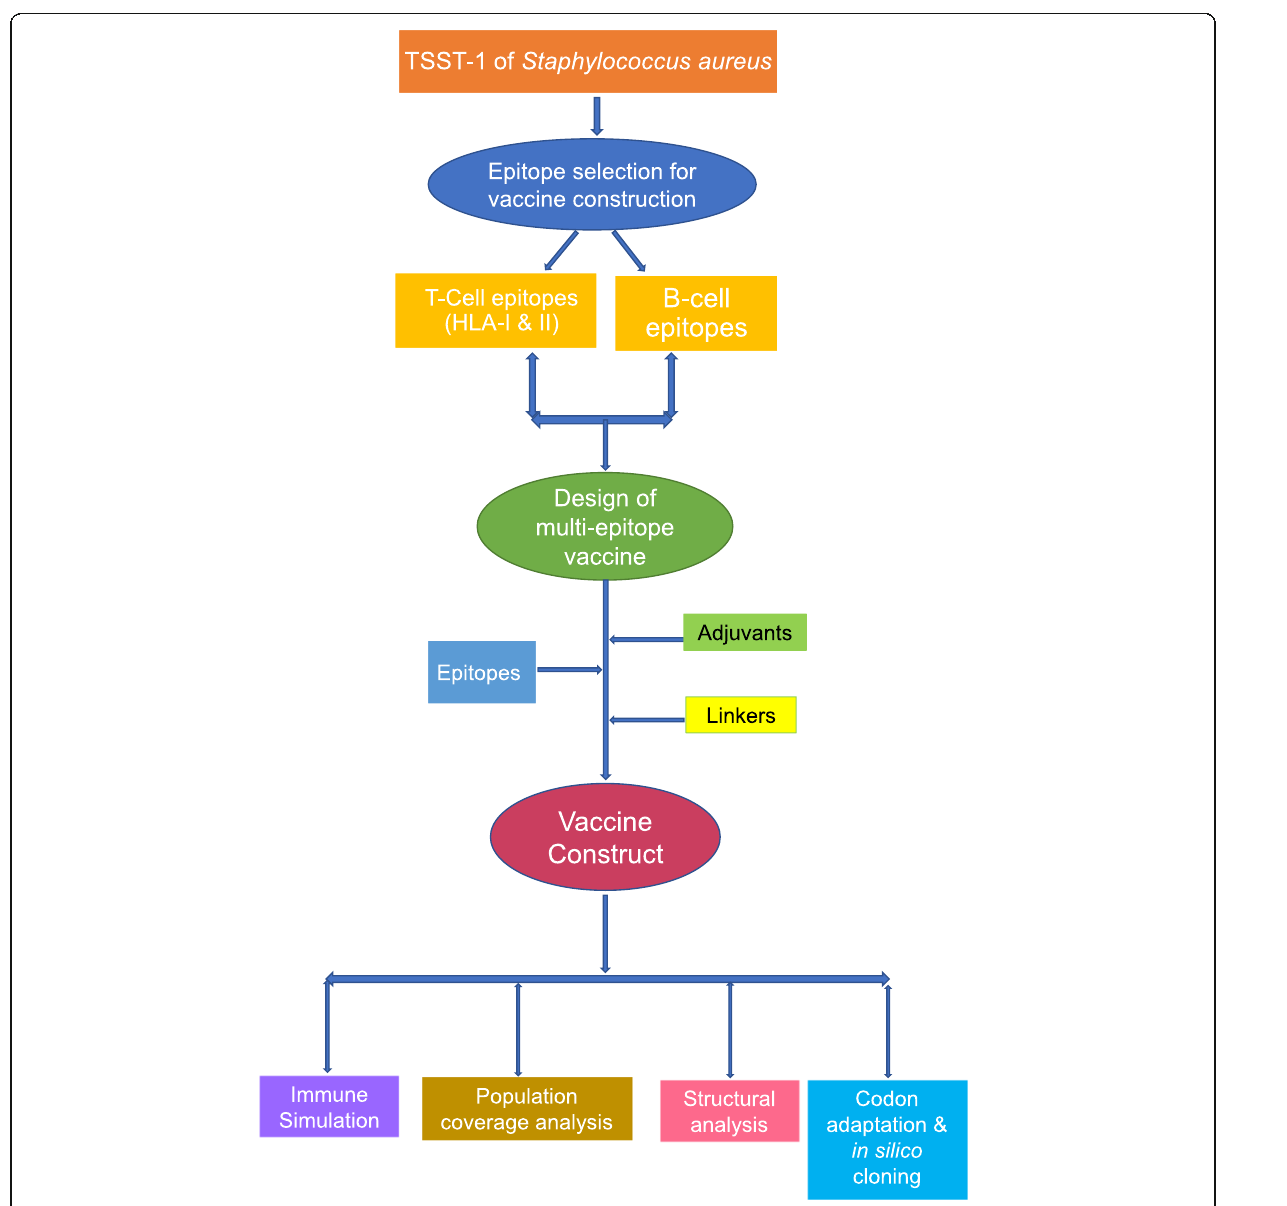
Fig. 1 Flow chart representing the schematic view of in silico design of multi epitope